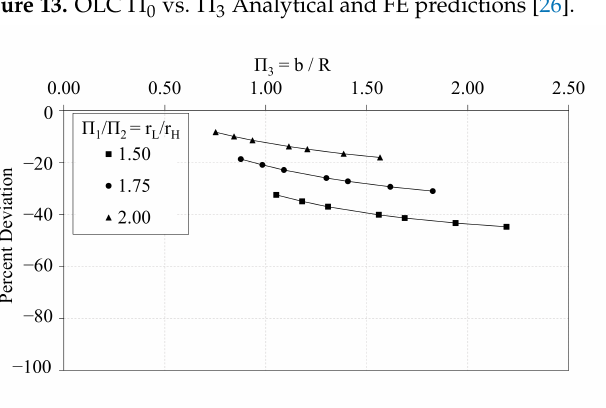
Figure 13. OLC Π 0 vs. Π 3 Analytical and FE predictions [26].